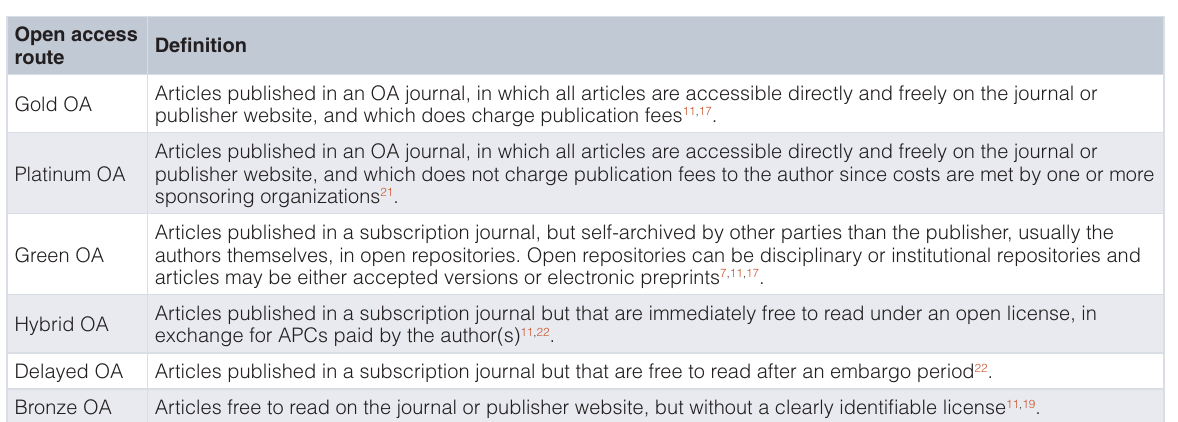
Table 1. Open access